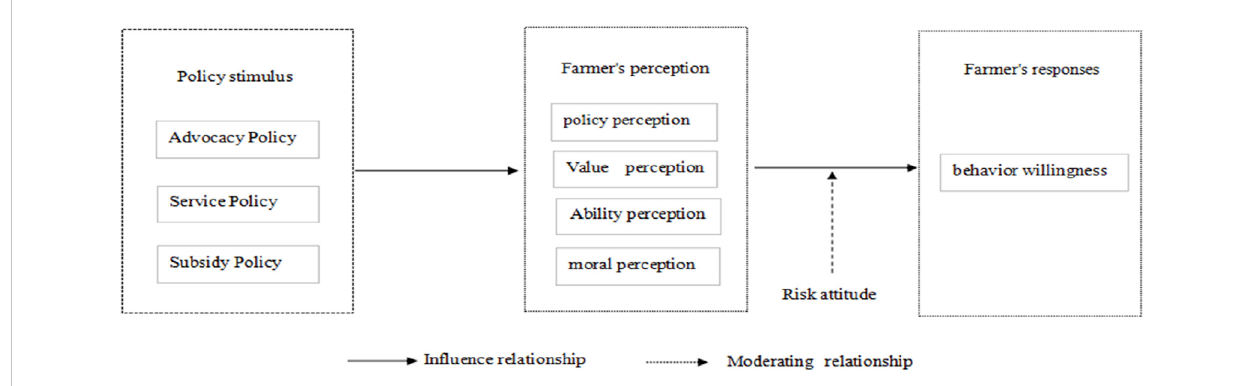
Theoretical model of support policy affecting farmers ’ willingness of resource